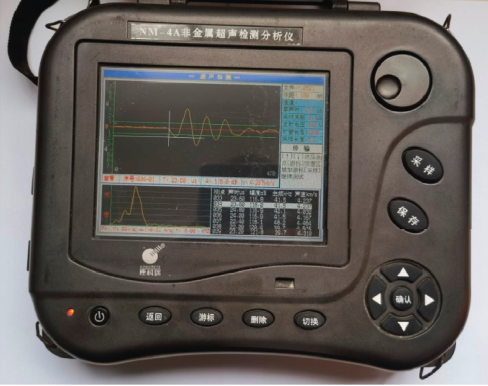
Figure 7: NM-4A ultrasonic detection analyzer. Table 6: Measured value of roof damage degree of the roadway in Maoping